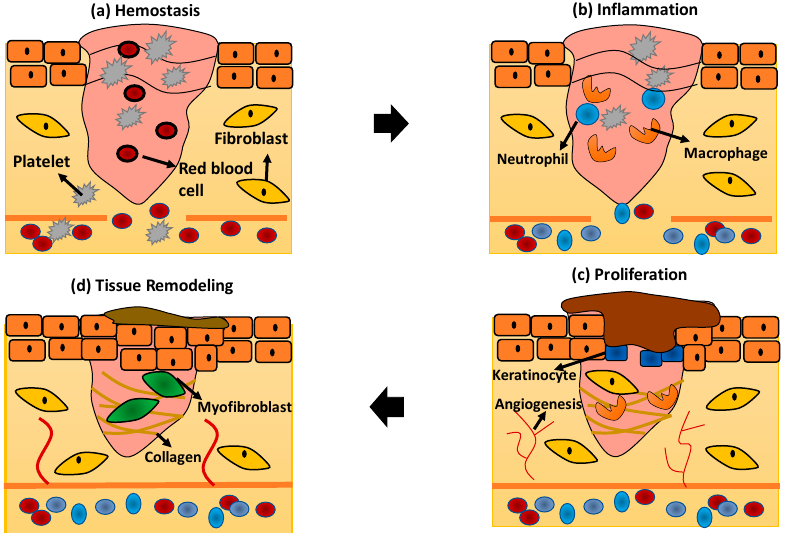
Figure 2. The wound healing phases ( a ) hemostasis; ( b ) inflammation; ( c ) proliferation; and ( d ) tissue remodeling.